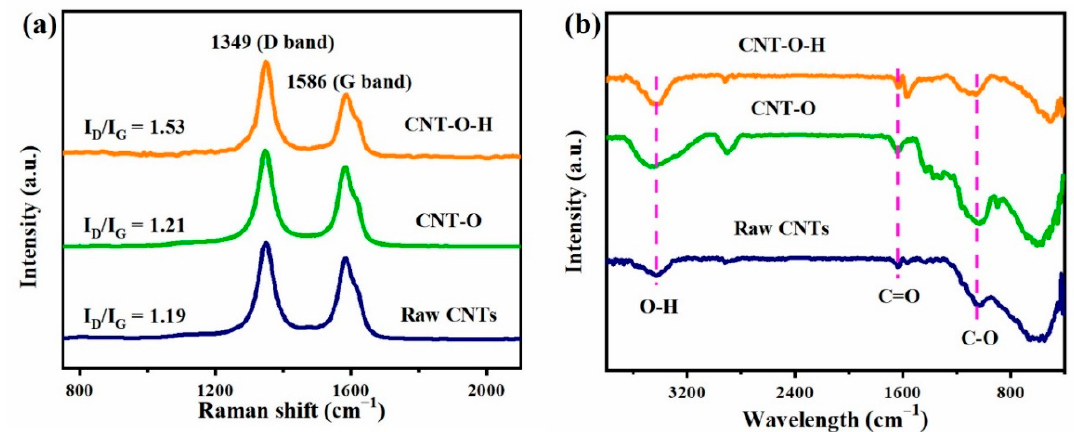
Figure 2. Raman spectra ( a ) and FTIR spectra ( b ) of raw CNTs, CNT-O and CNT-O-H.